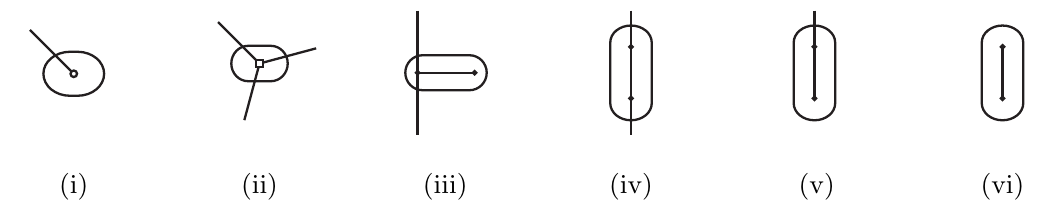
Figure 5. The six different types of components in a hierarchical decomposition tree.